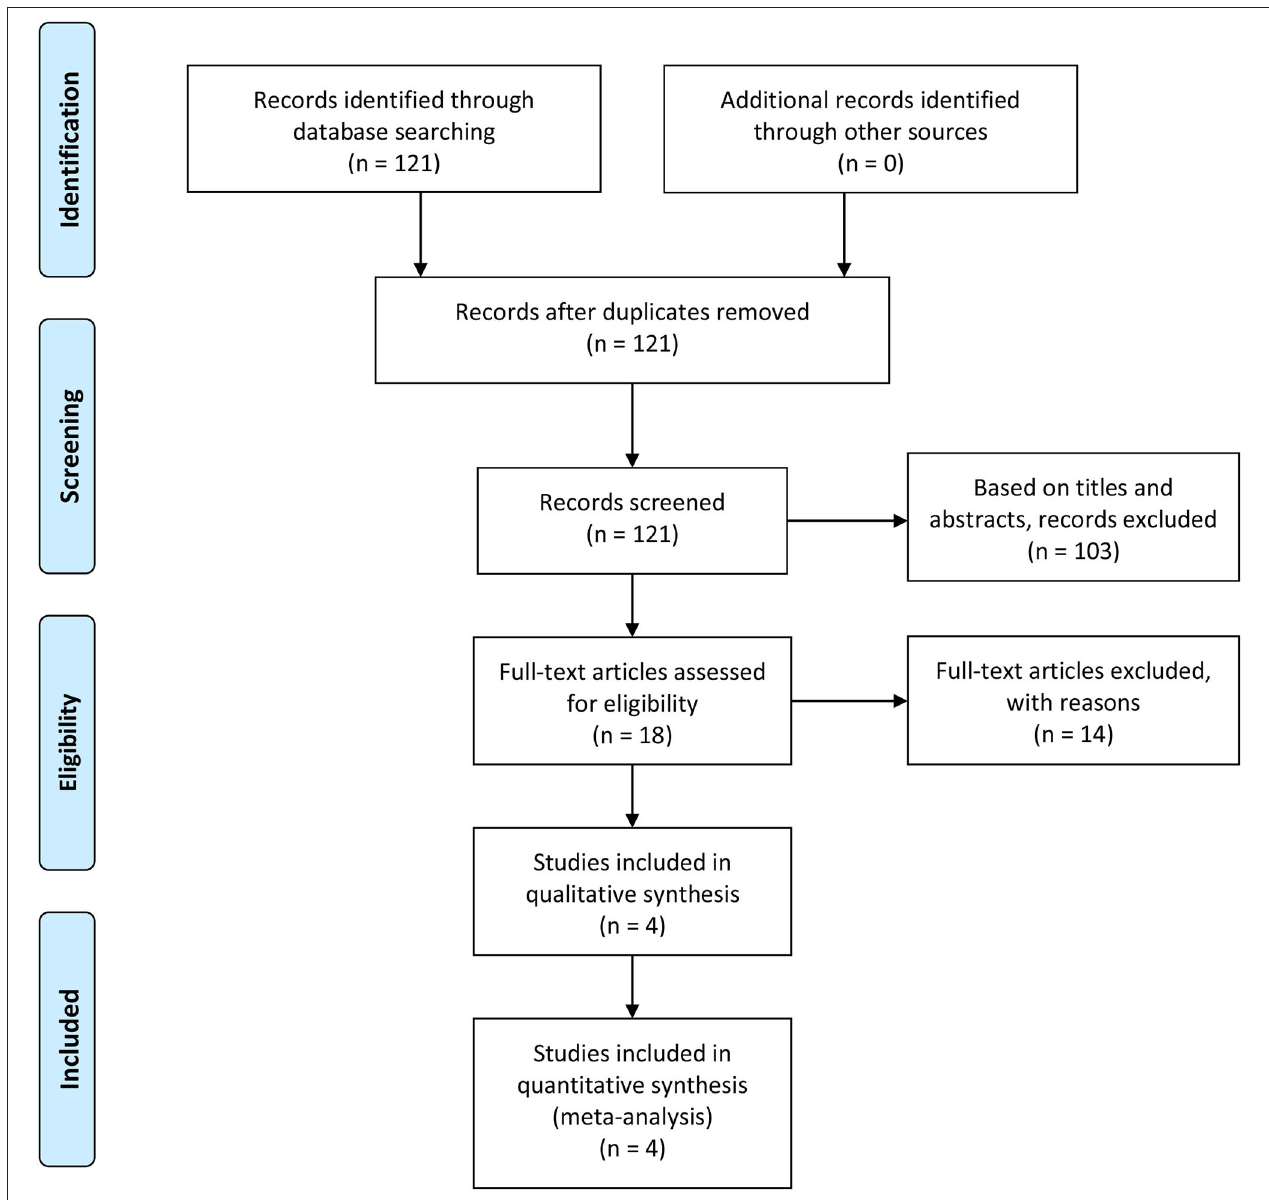
FIGURE 1 | The flowchart of selection PRISMA. RCTs, randomized controlled